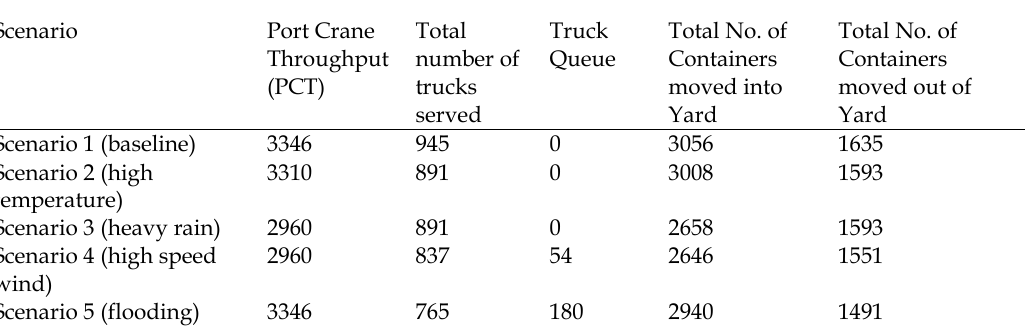
Table 10. Impact on daily